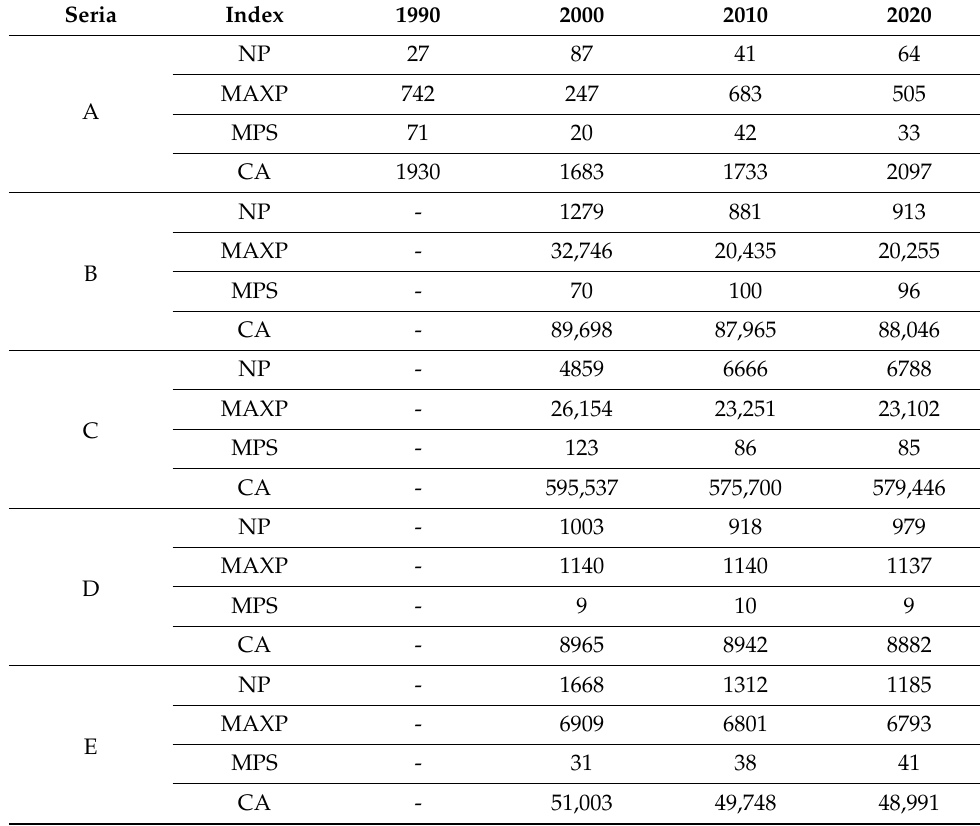
Table 5. Landscape matrix of the changed mangrove wetlands in five sites